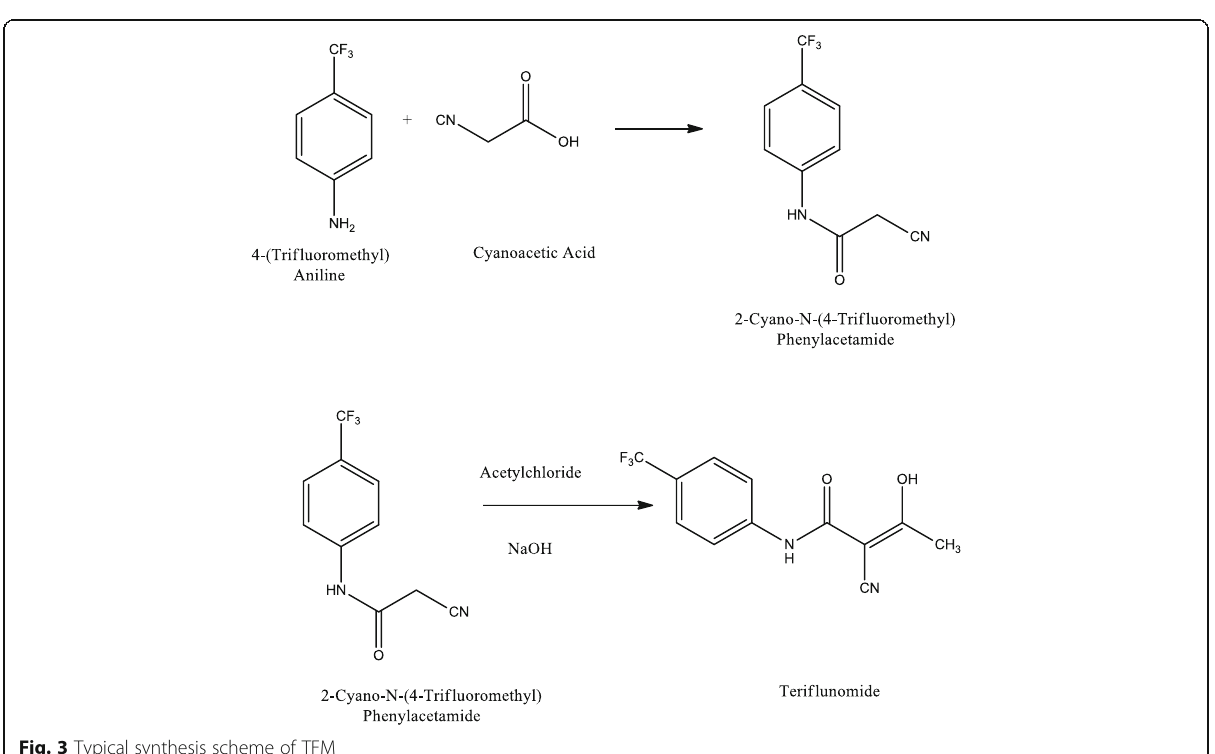
Fig. 3 Typical synthesis scheme of TFM